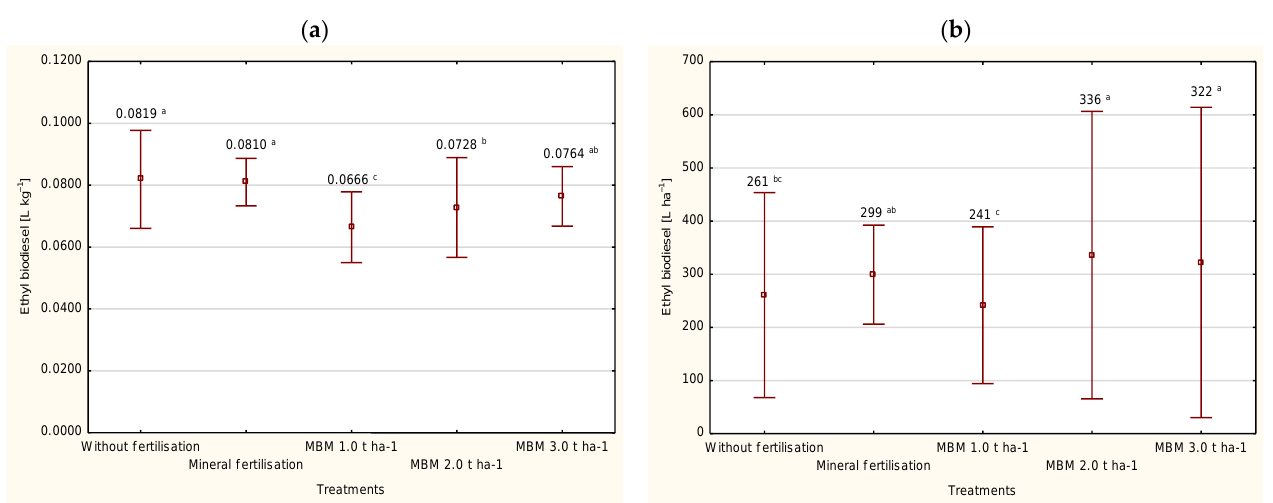
Figure 10. Volume of ethyl biodiesel obtained from corn grain (mean value and standard deviation), ( a ) and bioethanol yield from a hectare, ( b ) considering fertilization treatment. MBM — Meat and Bone Meal. a,b,c — Values followed by the same letters do not differ significantly in Tukey’s (HSD) test ( p < 0.05). Table 9. Interaction between the years and treatments for volume of ethyl biodiesel obtained from corn grain, and yield of ethyl biodiesel from a hectare, (mean value and standard deviation).